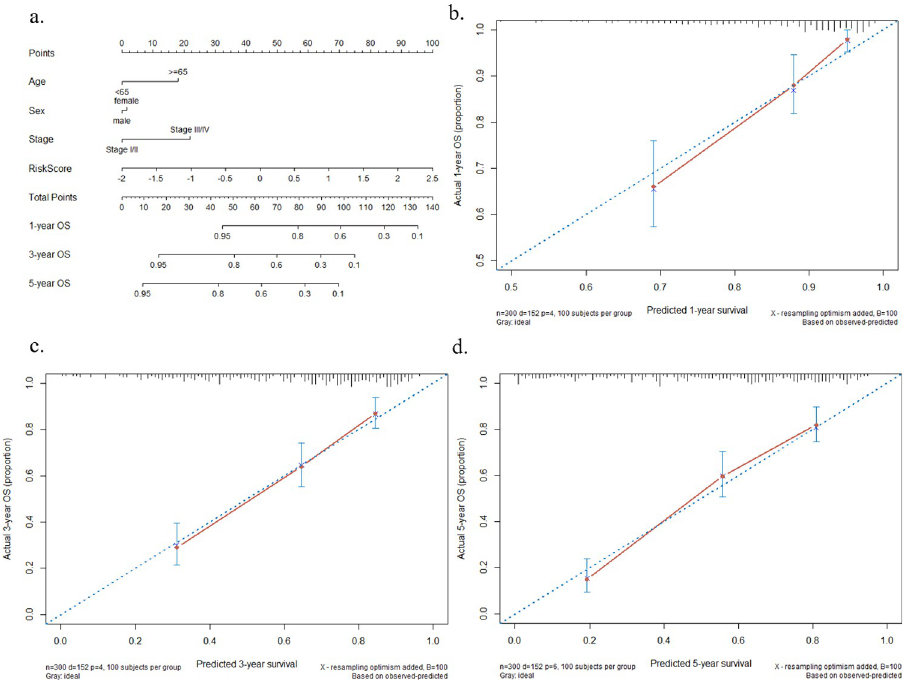
Fig 8. Nomogram and calibration plots for the prognostic model. a) Nomogram plotted by gene signature and clinical factors. b-d) Calibration plots demonstrating the consistency between predicted and observed 1-year, 3-year, and 5-year survival